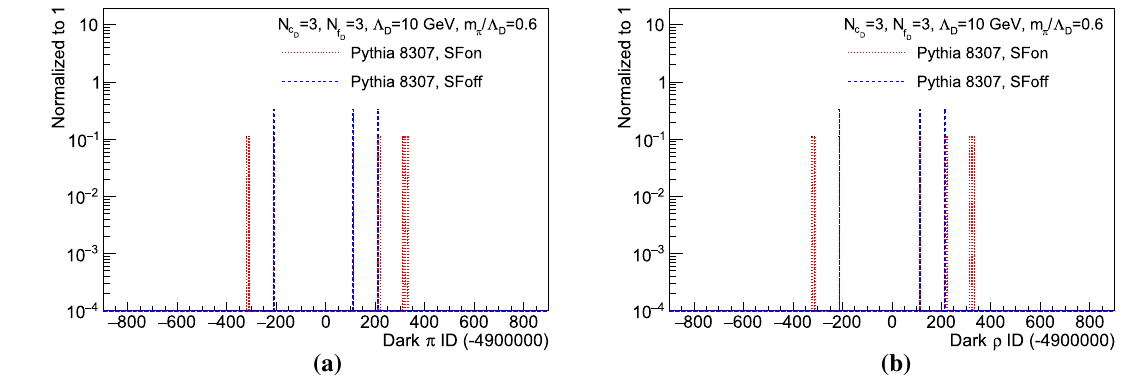
= 3, N = 3 model: a PdgId distribution for dark pions, b PdgId distribution for ρ Fig. 27 N c f D D